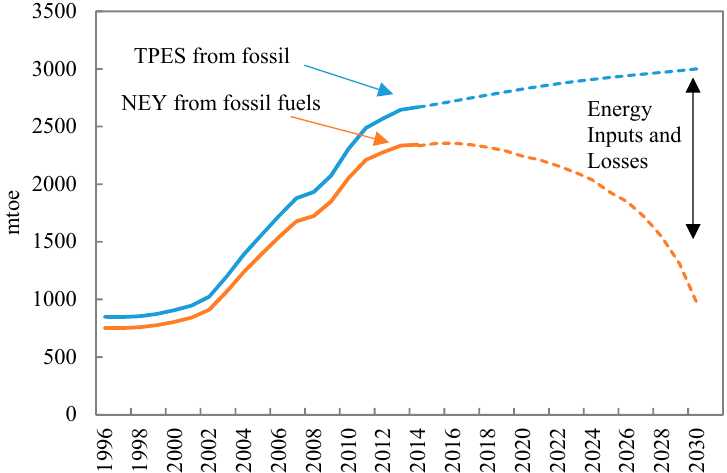
Figure 12. Peak net energy yields of Chinese fossil fuels appear in 2016. The gap is widening between TPES and net energy yields from fossil fuels because of the rapid decline in EROI POU .